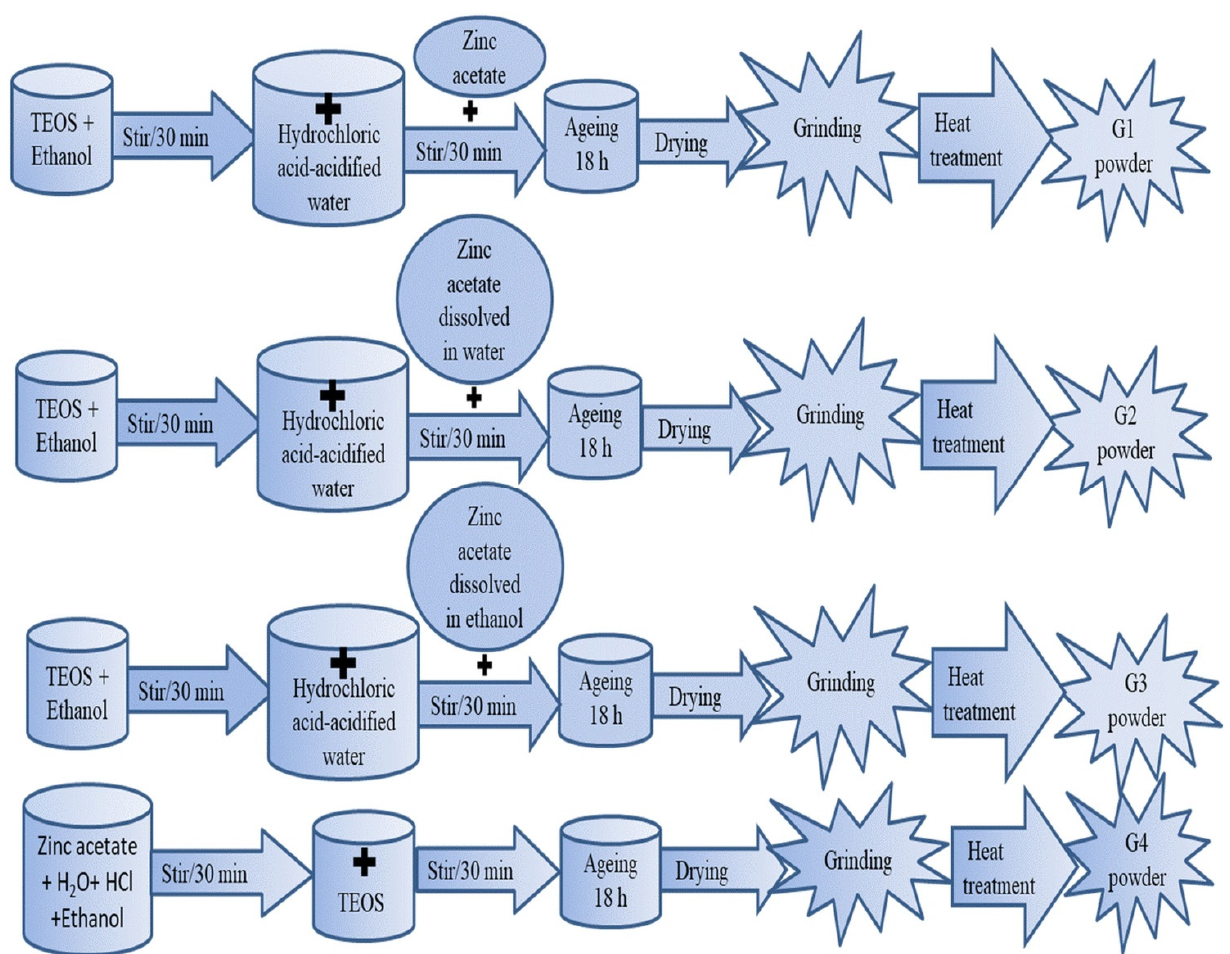
Figure 1. The synthesis schemes of G1–G4 powders.